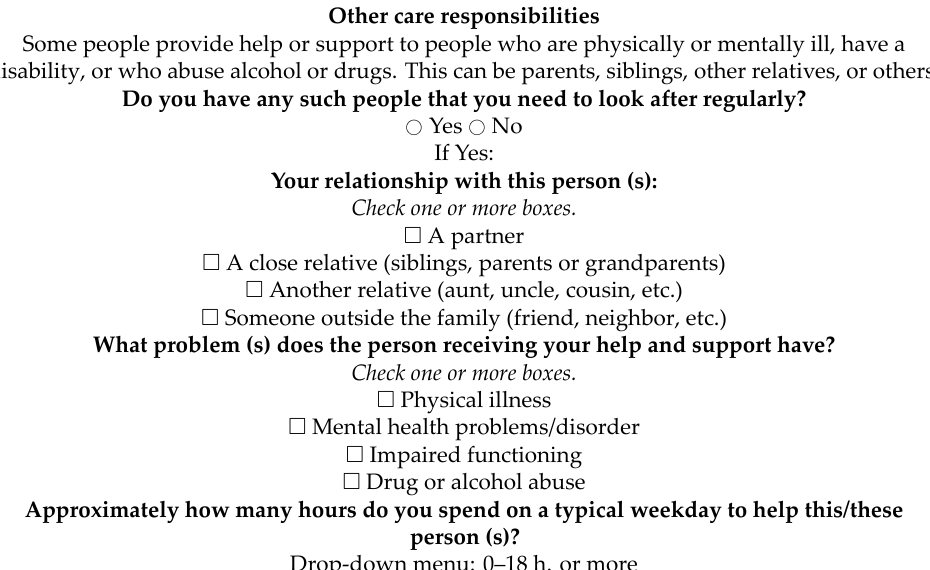
Table 1. Questionnaire assessing care responsibilities. Other care